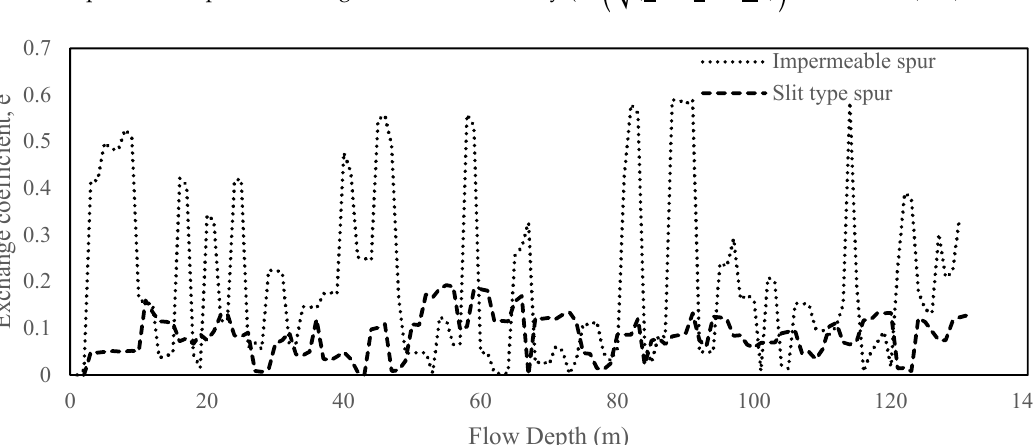
Figure 18. Visualization of the vortical structure of the mean flow using the Q criterion for slit-type and impermeable spurs. The magnitude of the velocity (= ((cid:3495)(cid:3435)𝑢 (cid:2870) + 𝑣 (cid:2870) + 𝑤 (cid:2870) (cid:3439)) is shown in (m/s).